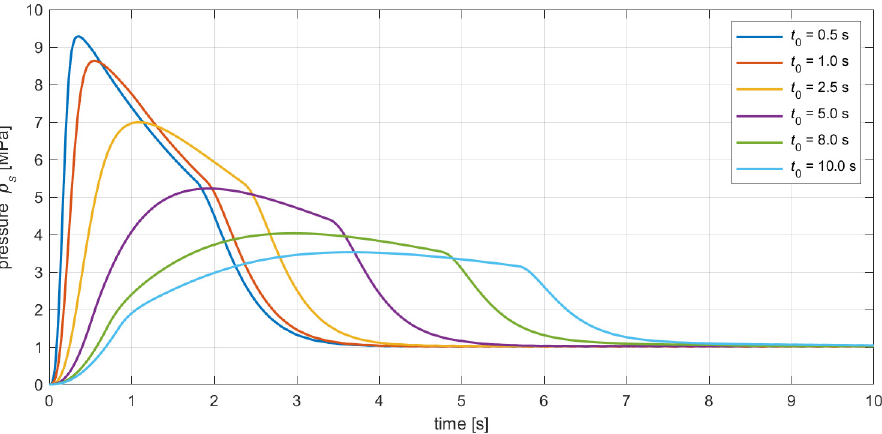
Figure 6. Result of simulation of the waveform of pressure on the motor p s for various signal rise times, t 0 .